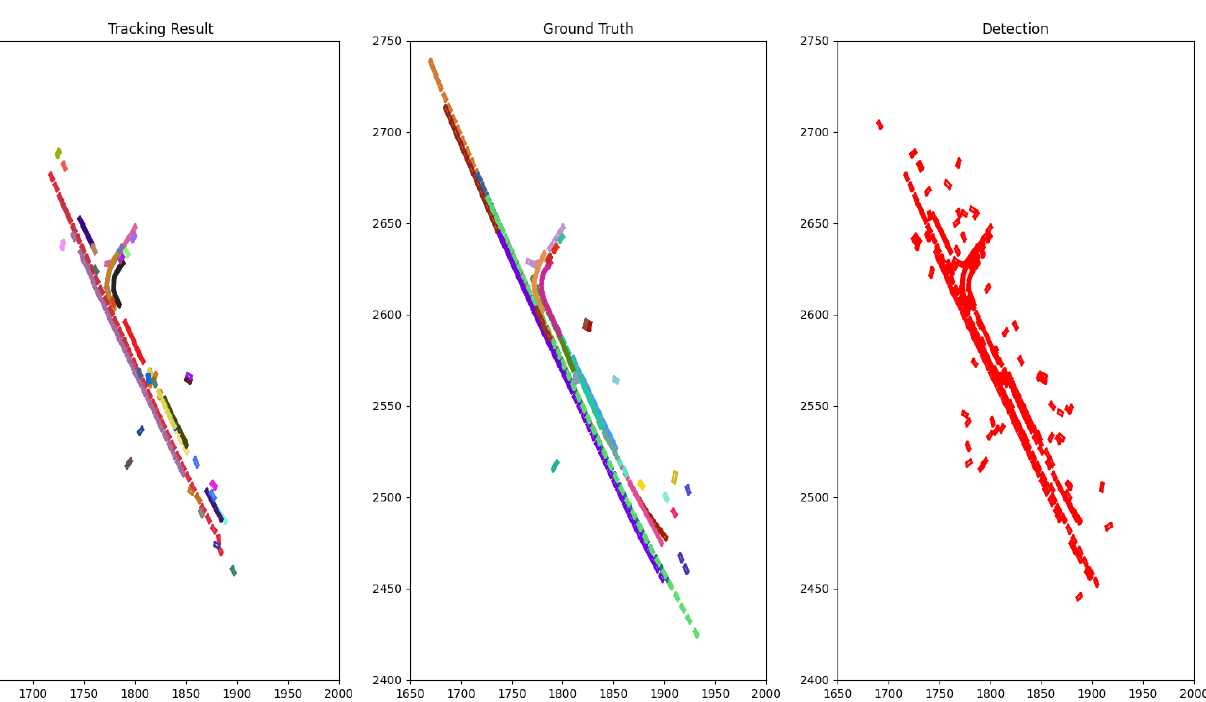
Figure 3. The bird-eye view of the tracking result for class car compared to the ground truth of scene 0796 (NuScenes) accumulated through time. Each rectangle represents a car and each color is associated with a track